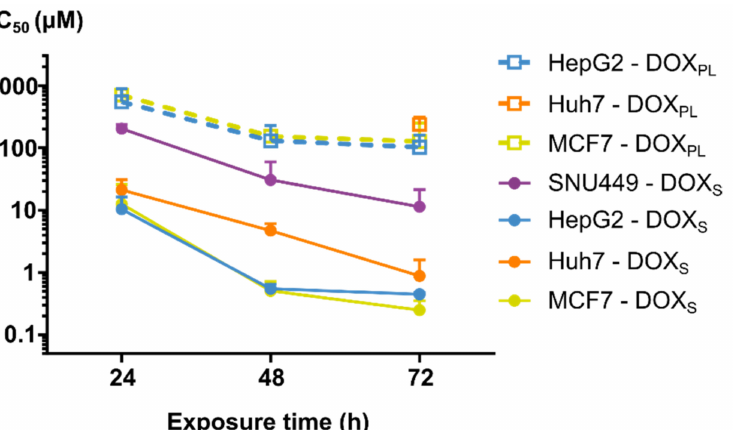
Figure 1. The mean ( ± SD) IC 50 values for different treatments during the three exposure times (24 h, 48 h and 72 h). The anti-tumor responses in the different cell lines (SNU449 in purple, HepG2 in blue, Huh-7 in orange and MCF7 in yellow) using the two study formulations (hollow squares for DOX PL , circles for DOX S ) are shown over the three different exposure times. The results for Huh-7 and SNU449 cells treated with DOX PL were excluded (except for Huh-7 at 72 h, where only one out of three replicates was excluded), as the maximum dose was too low to calculate the IC 50